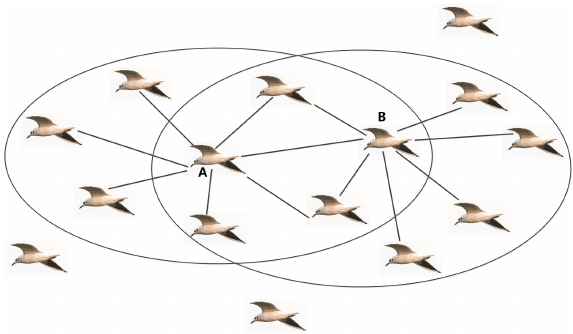
Figure 1. Visual reference diagram of starlings A and B in a formation.